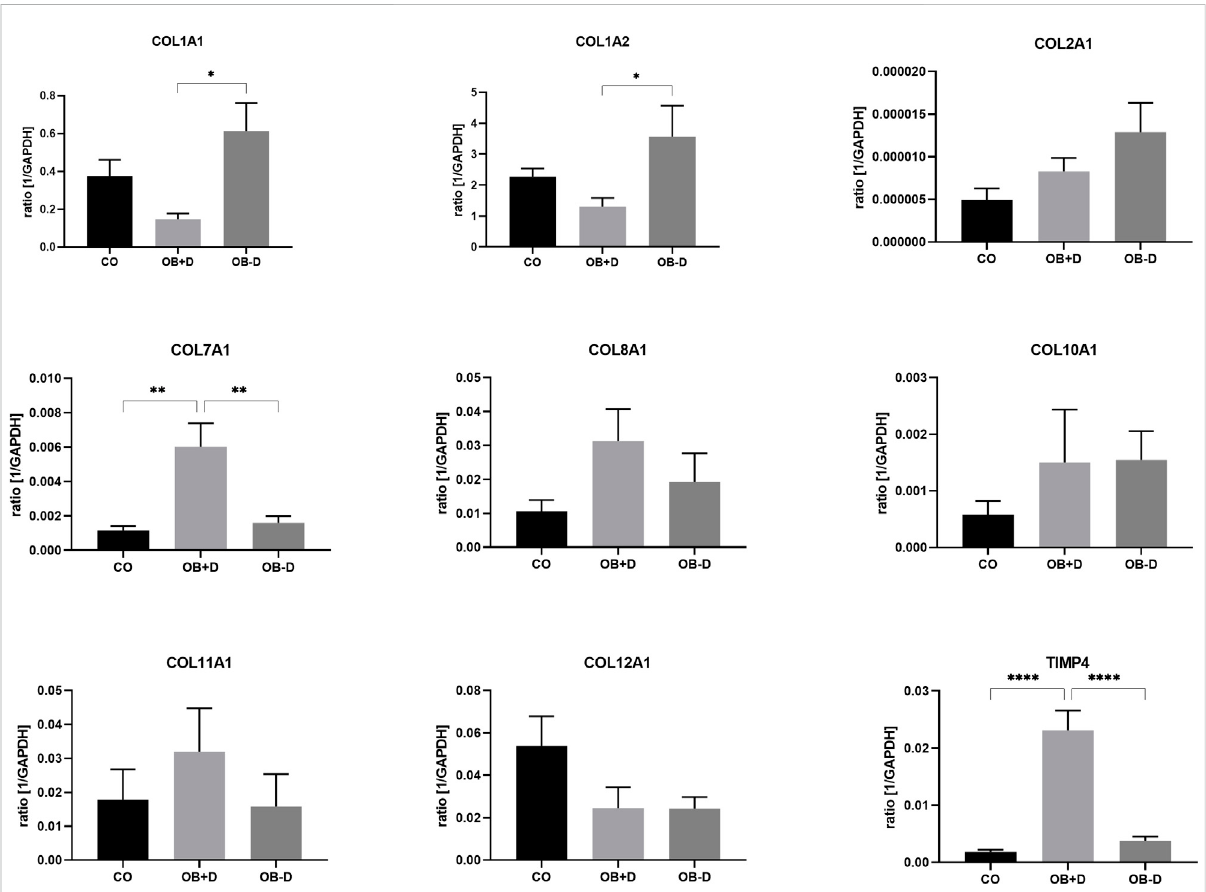
FIGURE 7 Expression of ECM-related genes by JPCs cultured for 15 days with control medium (CO) and osteogenic medium with (OB+D) and without (OB − D) dexa. Mean ± SEM values of mRNA copy numbers normalized by the housekeeping gene (GAPDH) were calculated and compared using one-way ANOVA and Tukey ’ s multiple comparison test (n = 7, * = p < 0.05, ** = p < 0.01, **** = p <